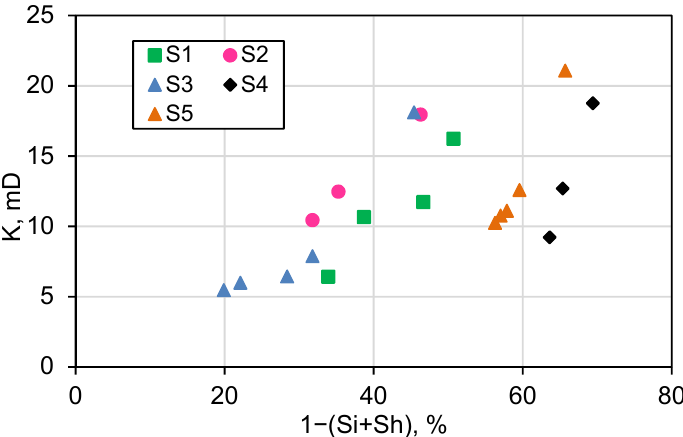
Figure 5. Gas permeability of frozen sand vs. relative pore space volume (1 − (Si + Sh)) during hydrate formation at − 5 ◦ C.